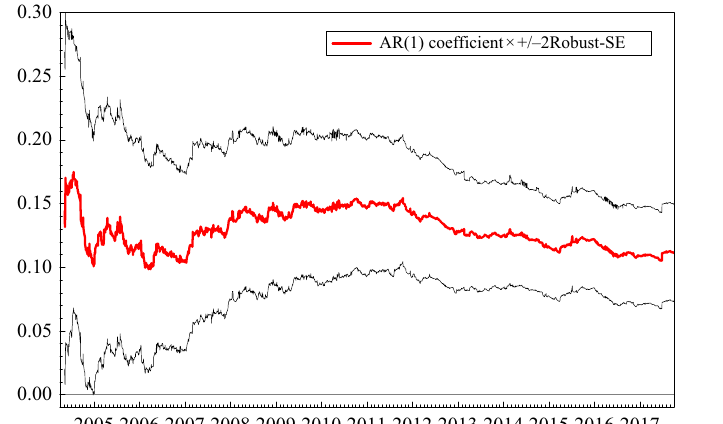
Figure 3. Evolution of market efficiency in